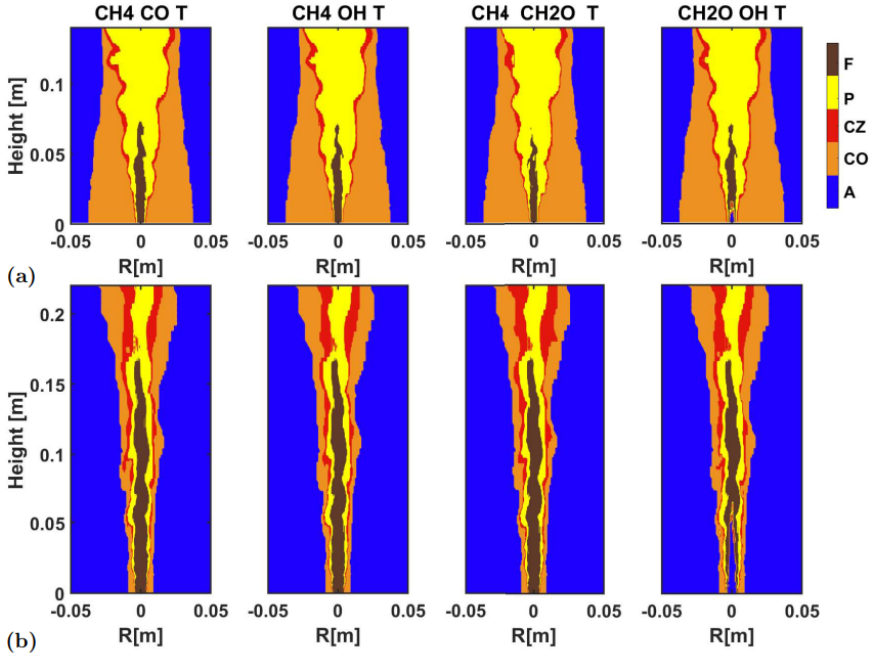
Figure 11. CRI results of BPNN with three-dimensional input: ( a ) HM1; ( b ) Sandia Flame D.